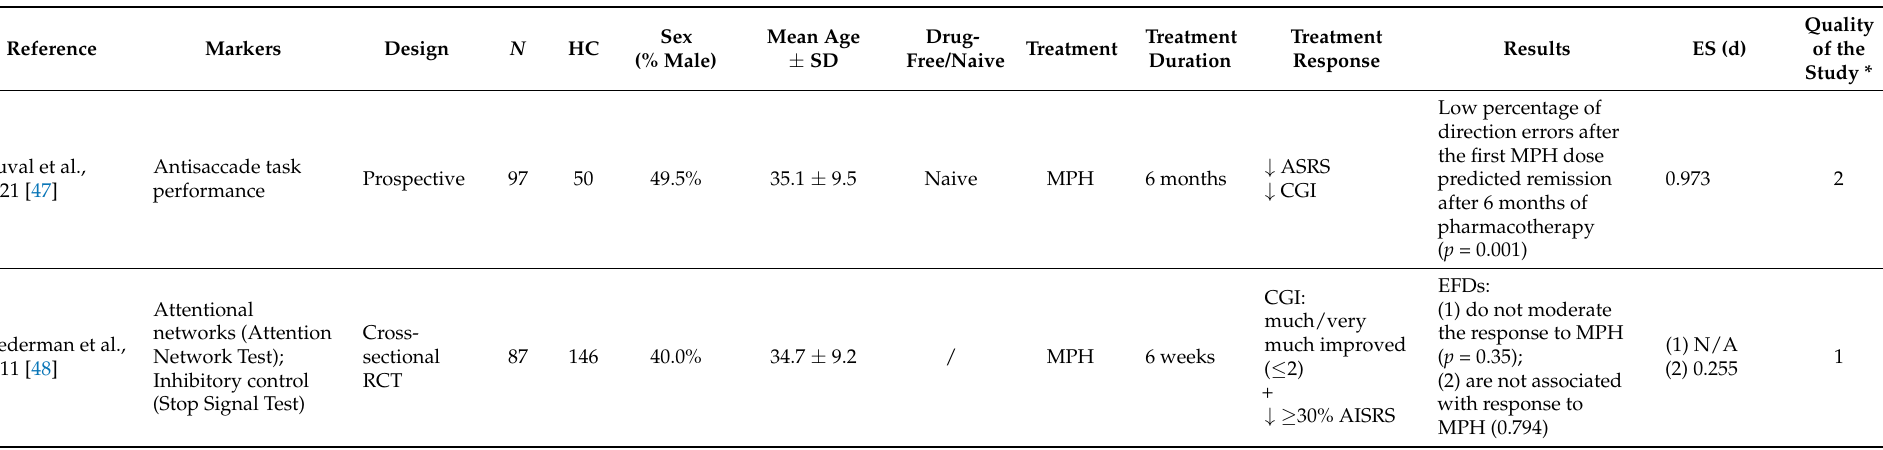
Table 3. Summary of the studies about neurophysiological markers of treatment response in adult ADHD.